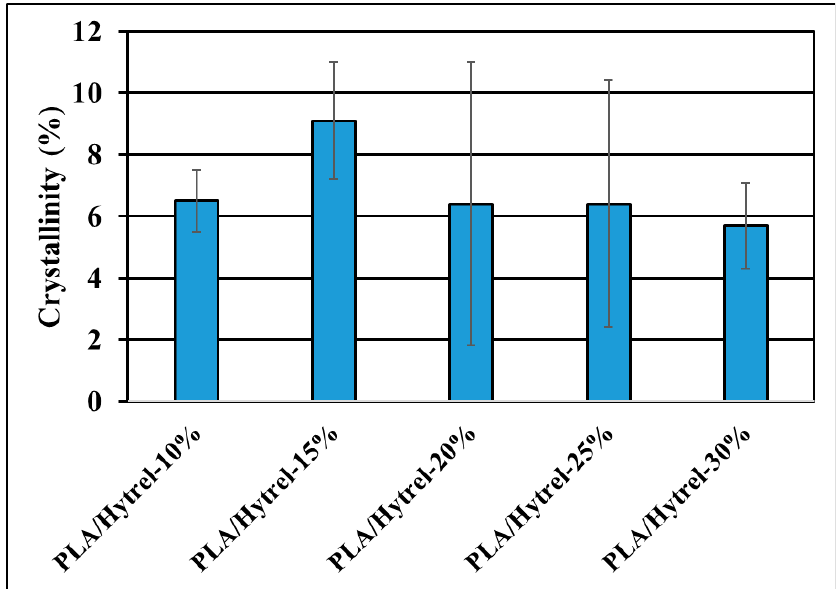
Figure 4. Crystallinity percentage calculated from the first thermal cycle (DSC) of the impact test